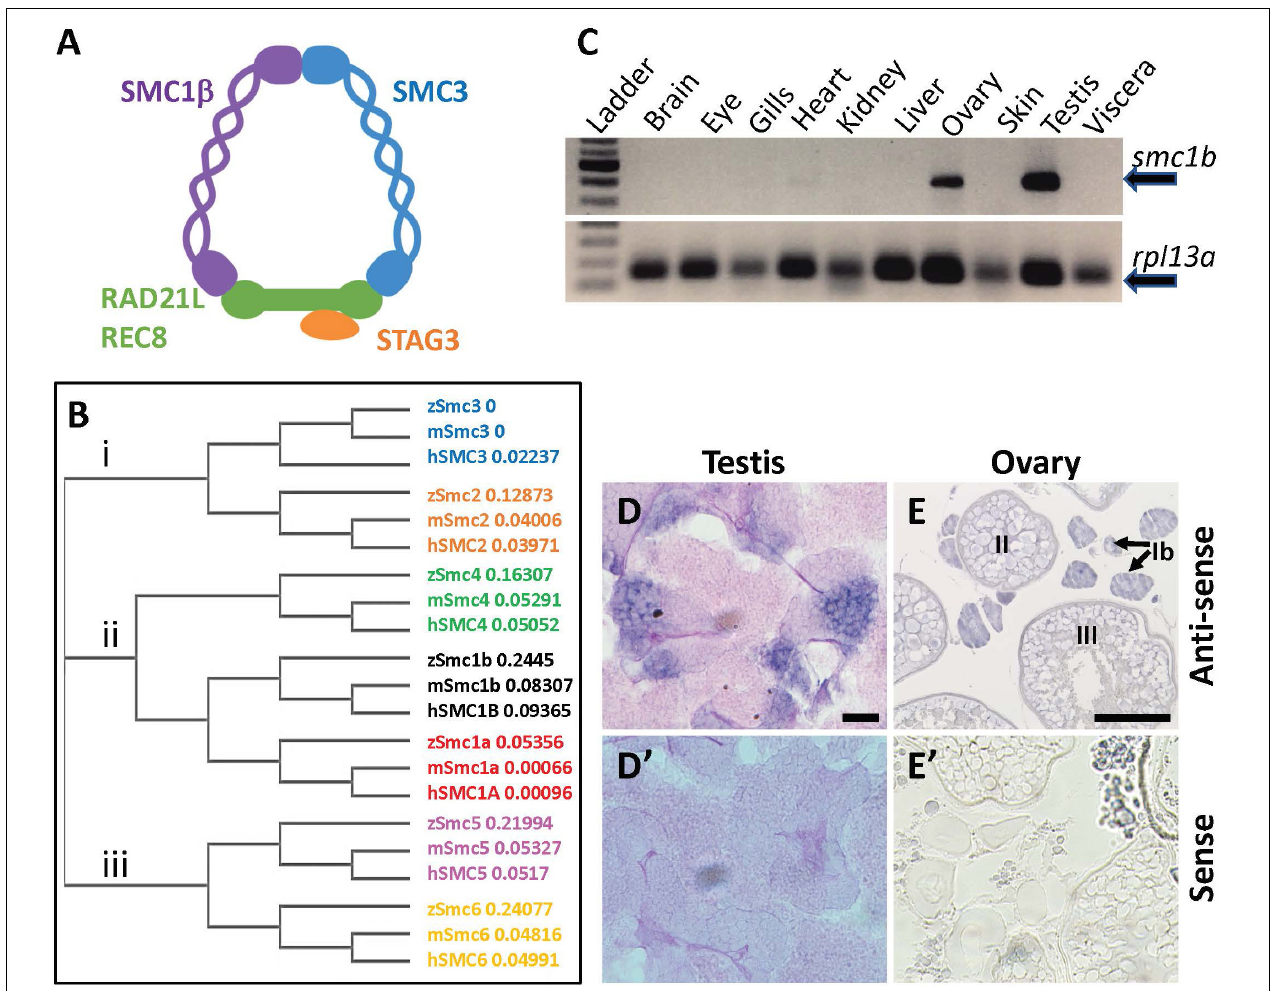
FIGURE 1 | Zebrafish smc1b is conserved and expressed in germ cells. (A) Cartoon representing the meiotic cohesin complex. (B) Phylogenetic tree of zebrafish (z), mouse (m), and human (h) Smc protein family. Numbers to the right of protein names represent bootstrap confidence values. (C) RT-PCR of smc1b and control gene rpl13a using cDNA generated from brains, eyes, gills, hearts, kidneys, livers, ovaries, skin, testes, and viscera of wild-type adult zebrafish. (D,E) In situ hybridization (ISH) on testis (D) and ovary (E) sections of wild-type zebrafish. (D’,E’) ISH using sense probes were run as negative controls. Scale bars are 20 µ m for testes and 100 µ m for